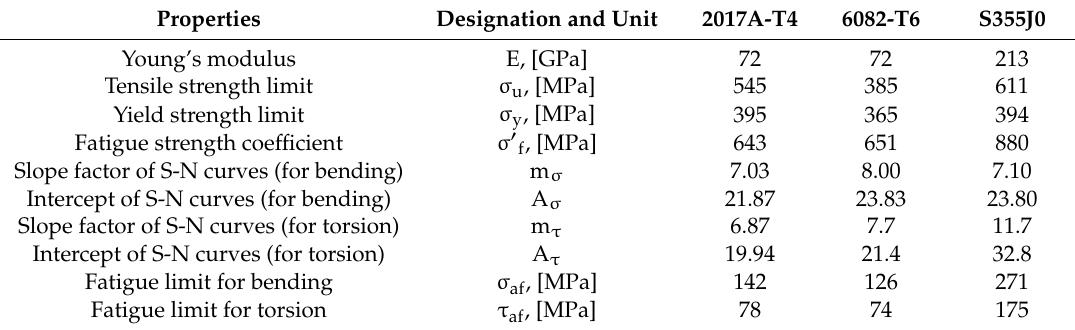
Table 1. Strength and fatigue properties of the analyzed materials.